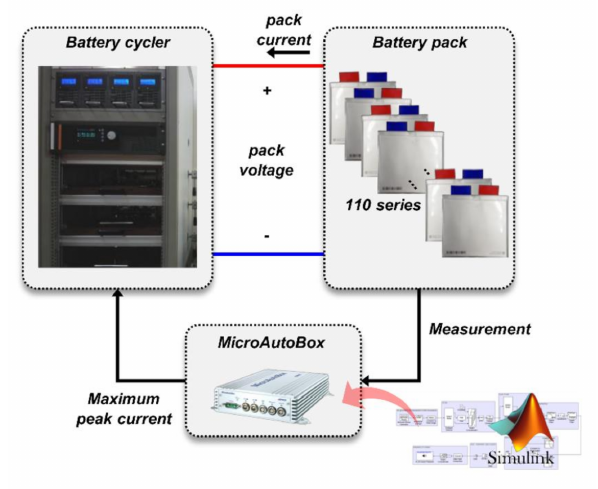
Figure 10. Experimental setup.